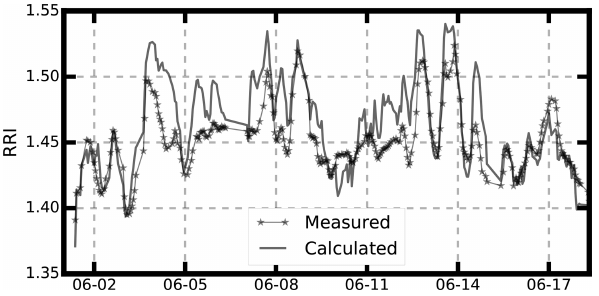
Figure 9. Time series of the measured RRI at 300nm and the cal- culated RRI using the aerosol bulk aerosol optical